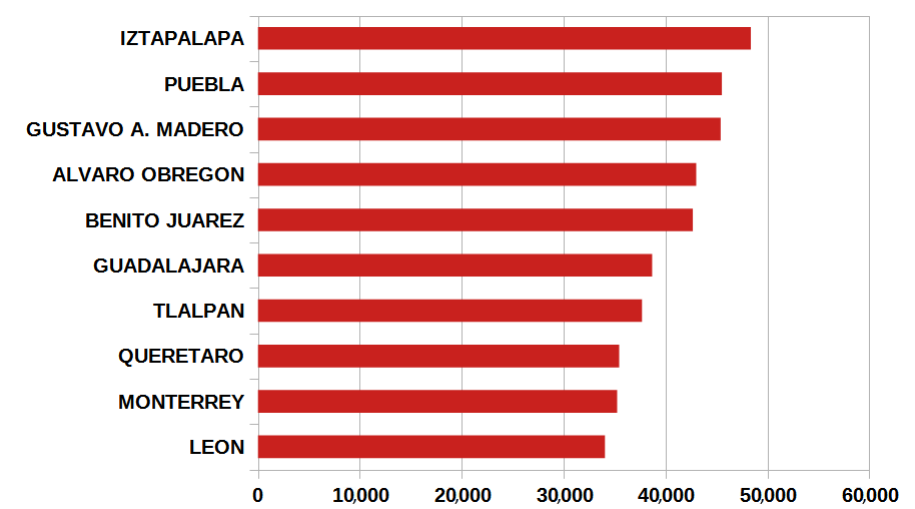
Figure 5. Municipalities with most COVID-19 cases from February 2020 to April